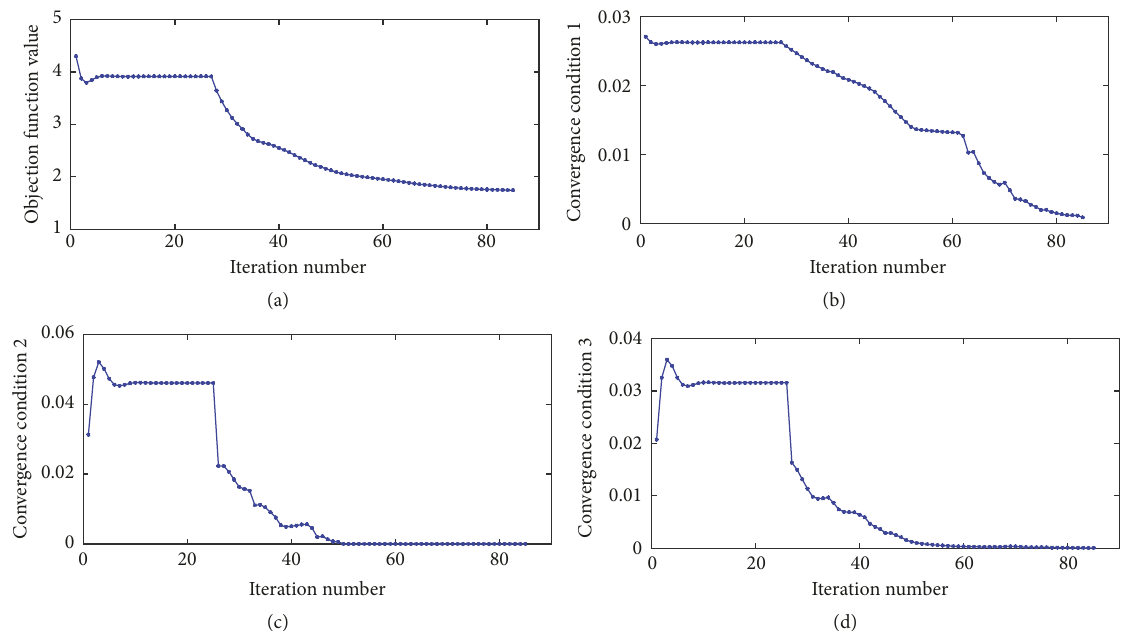
Figure 3: An illustration for the convergence property of Algorithm 1. (a) is the curve of objective function value versus iteration number. (b)-(d) are the curves of 3 convergence conditions in optimization versus iteration number: (b) ‖ 𝑦 − 𝐴𝑥 − 𝑒 ‖ ∞ ; (c) ‖ 𝑣 − ̃ 𝑢 ‖ ∞ ; (d) ‖ 𝑅𝑥 − 𝑢 ‖ ∞ .